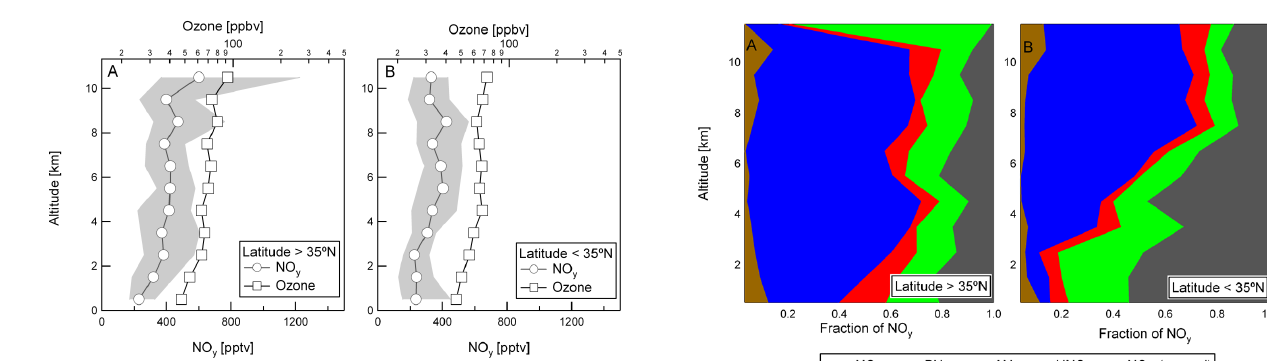
Figure 3: Vertical distribution of the partitioning of reactive nitrogen (NO y ) between NO x 563 Fig. 3. Vertical distribution of the partitioning of reactive nitrogen (brown), Σ PNs (blue), Σ ANs (red), HNO 3 (green) and particulate nitrate (grey) as observed 564 (NO y ) between NO x (brown), 6 PNs (blue), 6 ANs (red), HNO 3 during the INTEX-B field campaign over the North Pacific during the Spring of 2006 (April-565 May), North of 35ºN (panel A) and South of 35ºN (panel B). The fraction of NO y in each 566 (green) and particulate nitrate (grey) as observed during the INTEX- altitude bin was calculated from the median profile in each of the individual constituents. 567 B field campaign over the North Pacific during the Spring of 2006 568 (April–May), North of 35 ◦ N (A) and South of 35 ◦ N (B) . The frac- 569 570 tion of NO y in each altitude bin was calculated from the median profile in each of the individual